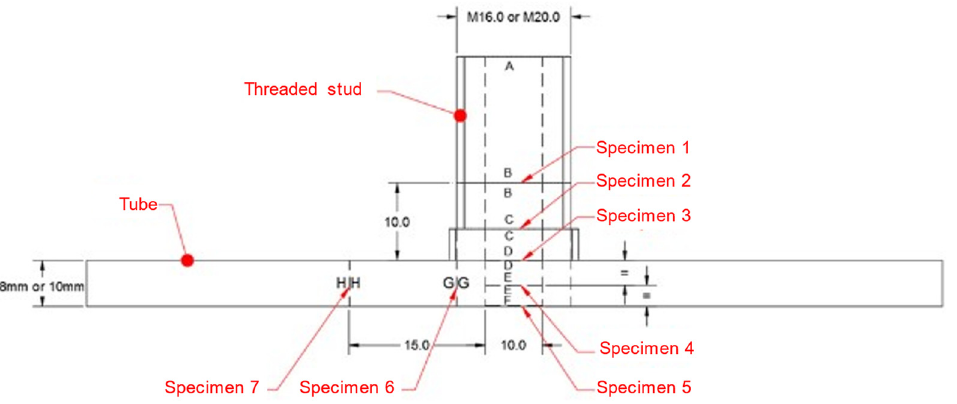
Figure 3. Procedure for preparing the samples through band saw and Wire Electrical Discharge Machining (WEDM).